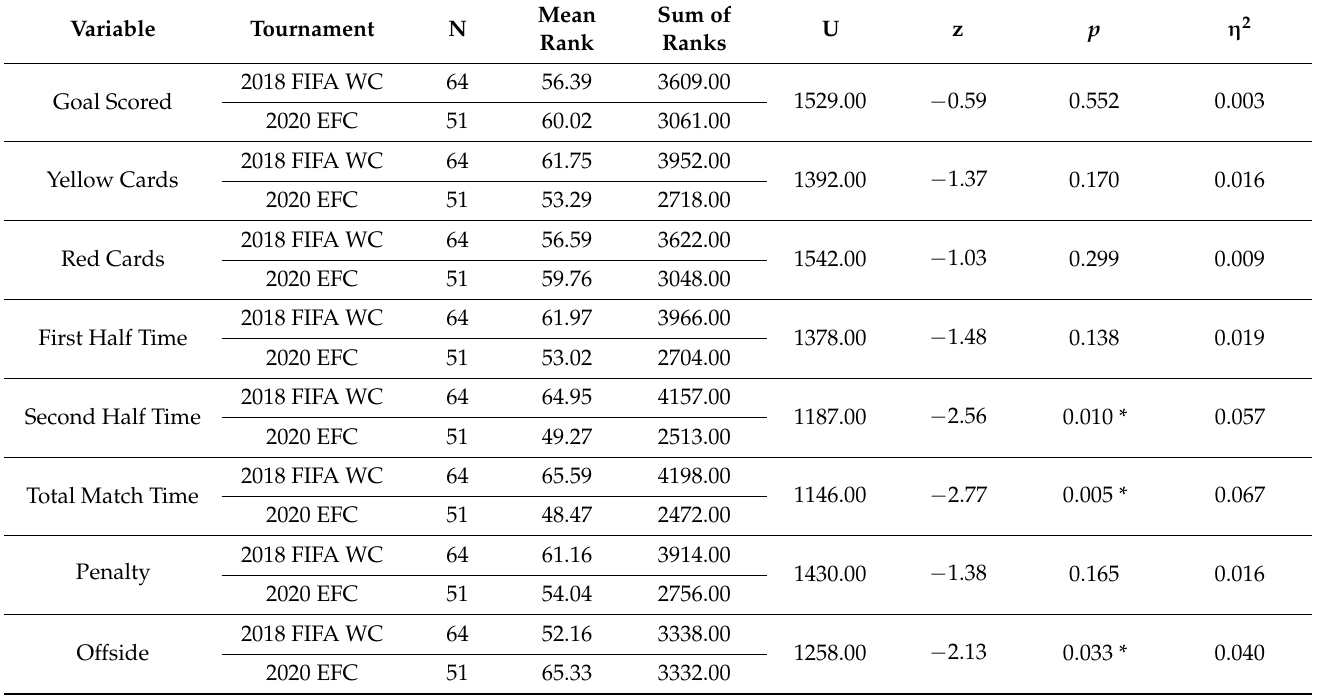
Table 1. Mann–Whitney U test results of the VAR application in 2018 FIFA World Cup and 2020 European Football